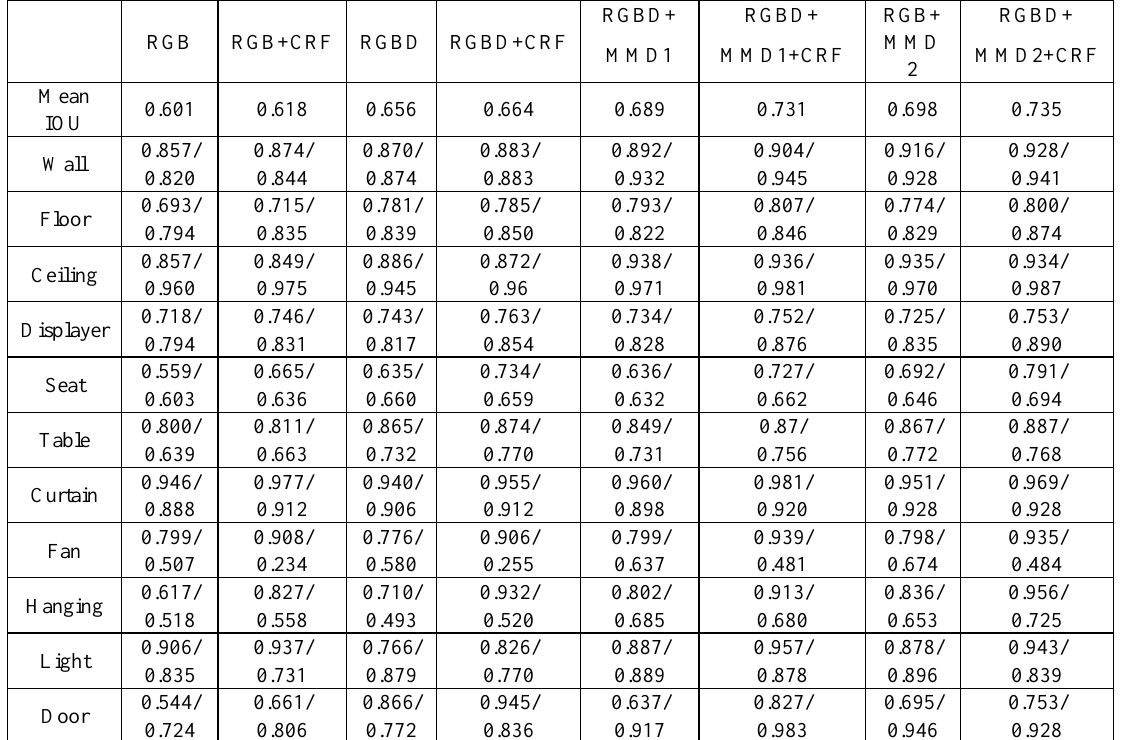
Table 2. Performance of semantic segmentation by eight methods (precision/recall and mean IOU)